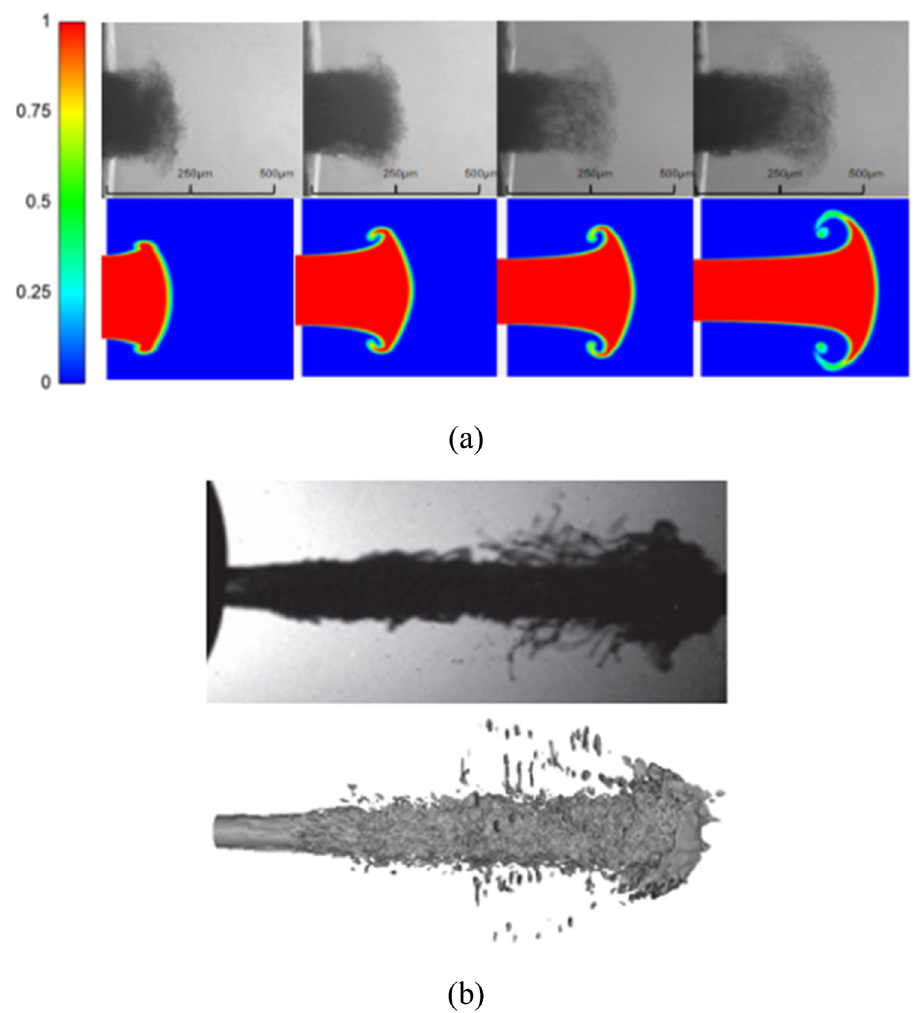
Figure 4: Comparison of numerical and experimental results including ( a ) the initial state of injection [ 54 ] and ( b ) the fully developed cavitation jet [ 53,54 ] .